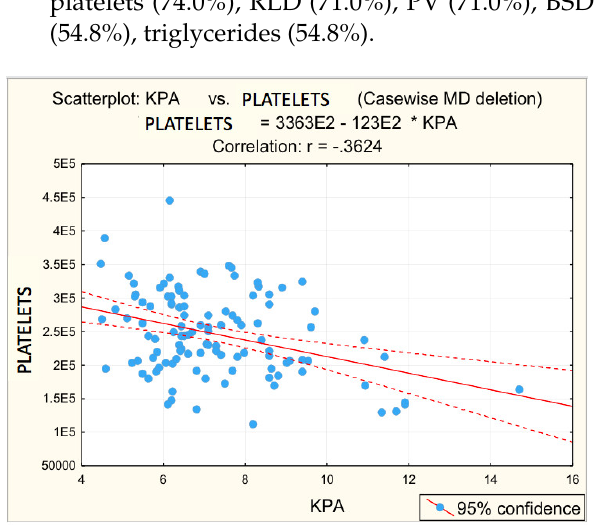
Figure 3. Correlation platelets— fibrosis . (E2 = 10 2 , * = multiplication, -.3624 = −0.3624).